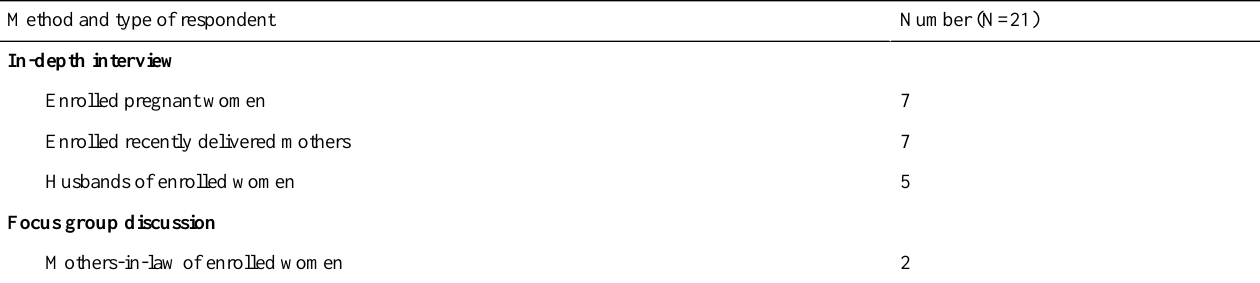
Table 1. Methods, numbers, and types of respondents for the qualitative information.